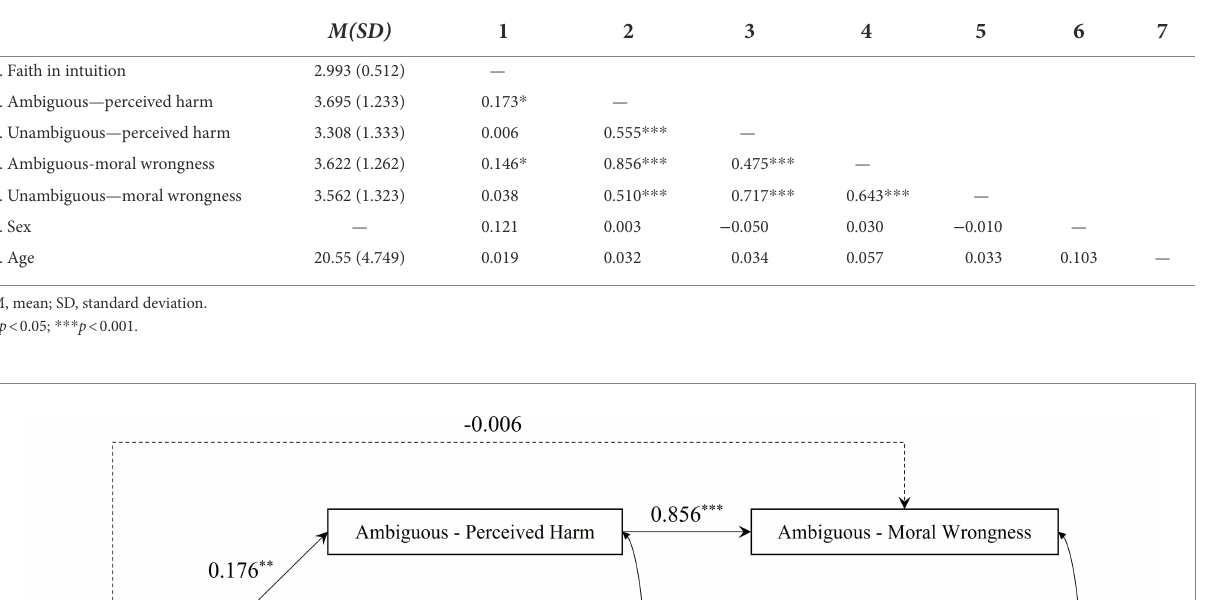
TABLE 2 Descriptive statistics and correlation analysis results of Experiment 2.